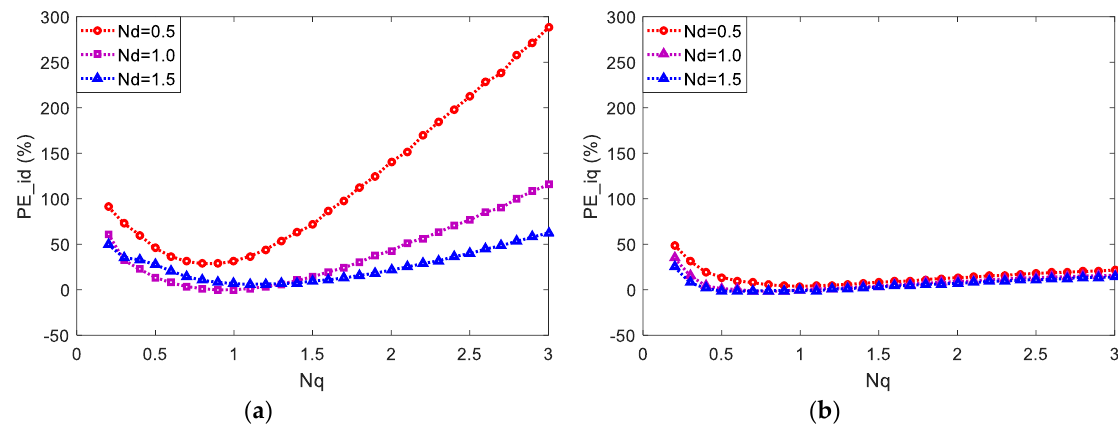
Figure 8. Relative prediction error under N q step changes for three N d settings. ( a ) Relative prediction error of i d ; ( b ) Relative prediction error of i q .